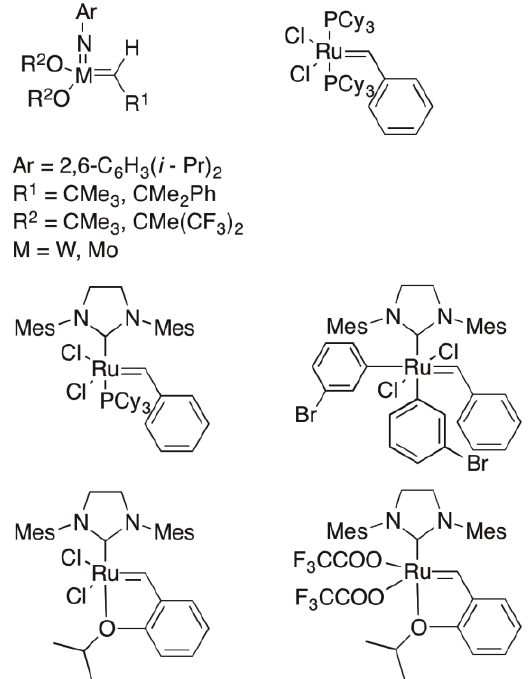
Figure 52. A selection of ROMP catalysts [135 –